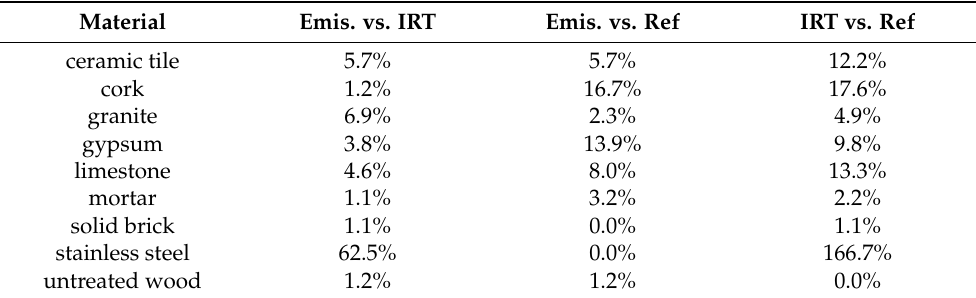
Table 8. Relative differences between emissivity values obtained with different methods (emissometer, IRT and manual mode of the IR